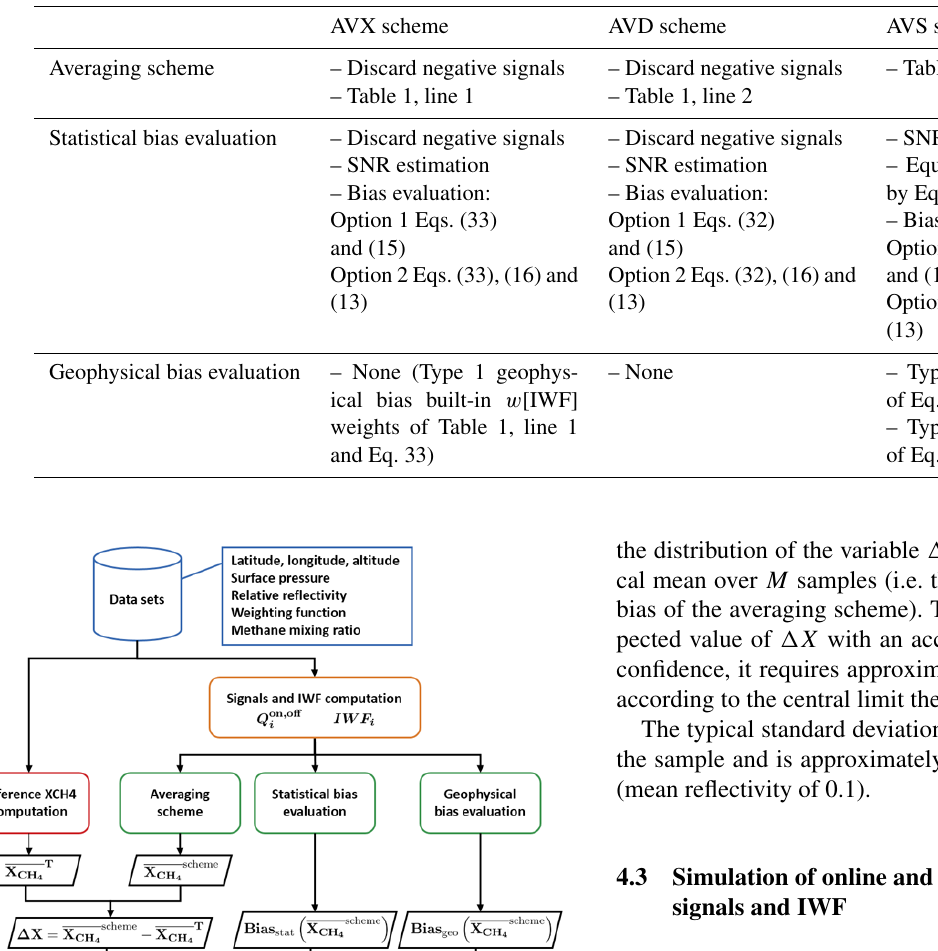
Table 5. Computational details about averaging schemes and bias evaluation.